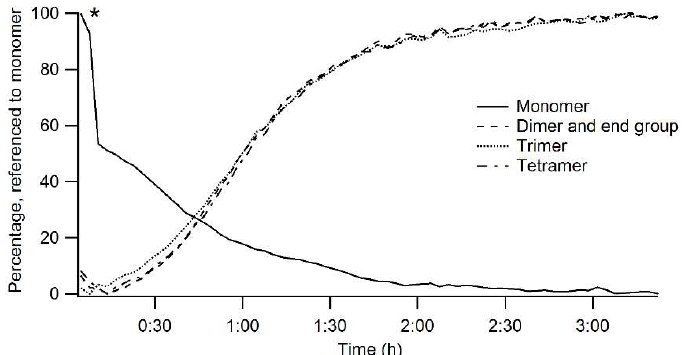
Figure 4. Raman intensities monitored during the pre-condensation step. All signals are referenced